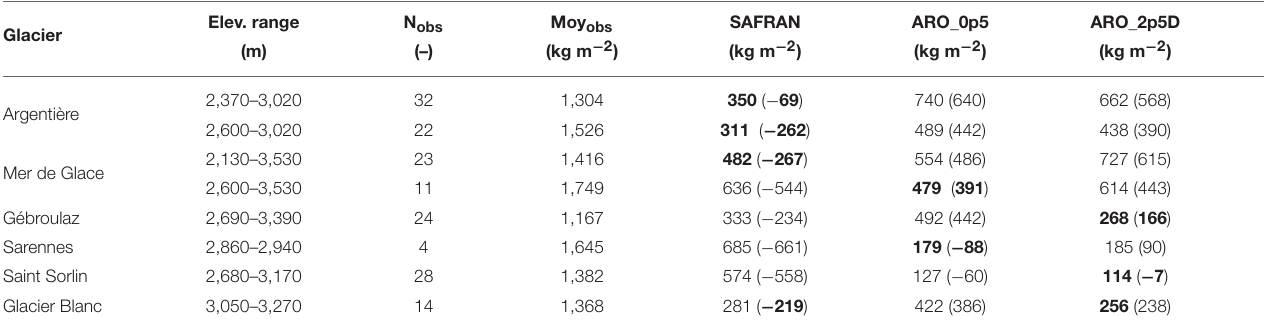
TABLE 3 | Error statistics (in kg m − 2 ) for simulated winter surface mass balance against observations collected at drilling cores for six glaciers of the French Alps for winter 2011–2012. Elev. Glacier